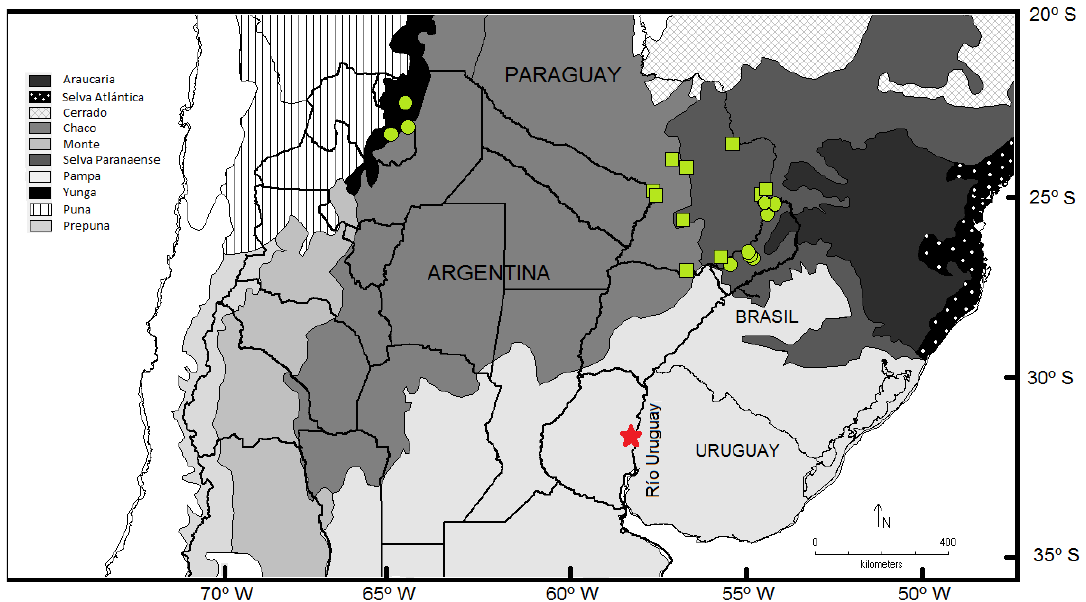
Figure 1. Distribution of Erythrolamprus reginae in Argentina (green circles) and Paraguay (green squares). The new southernmost locality for this species is shown by a red star. The map is constructed based on the biogeographic regionalization of Morrone (2014) obtained from Löwenberg-Neto